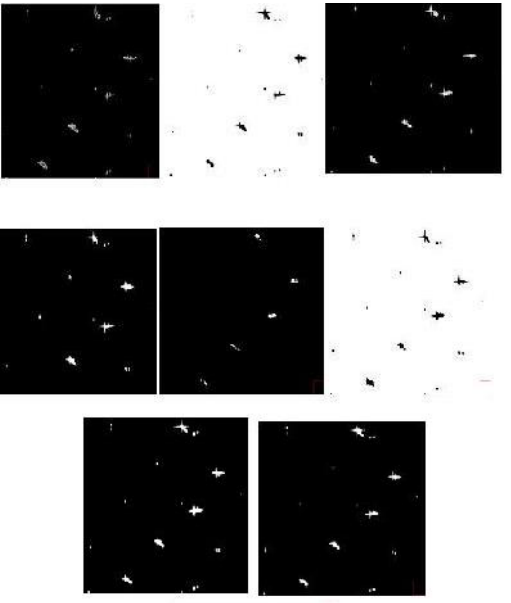
Figure 3. Co-occurrence texture features respectively from left to right: correlation, second moment, entropy, dissimilarity, contrast, homogeneity, variance and